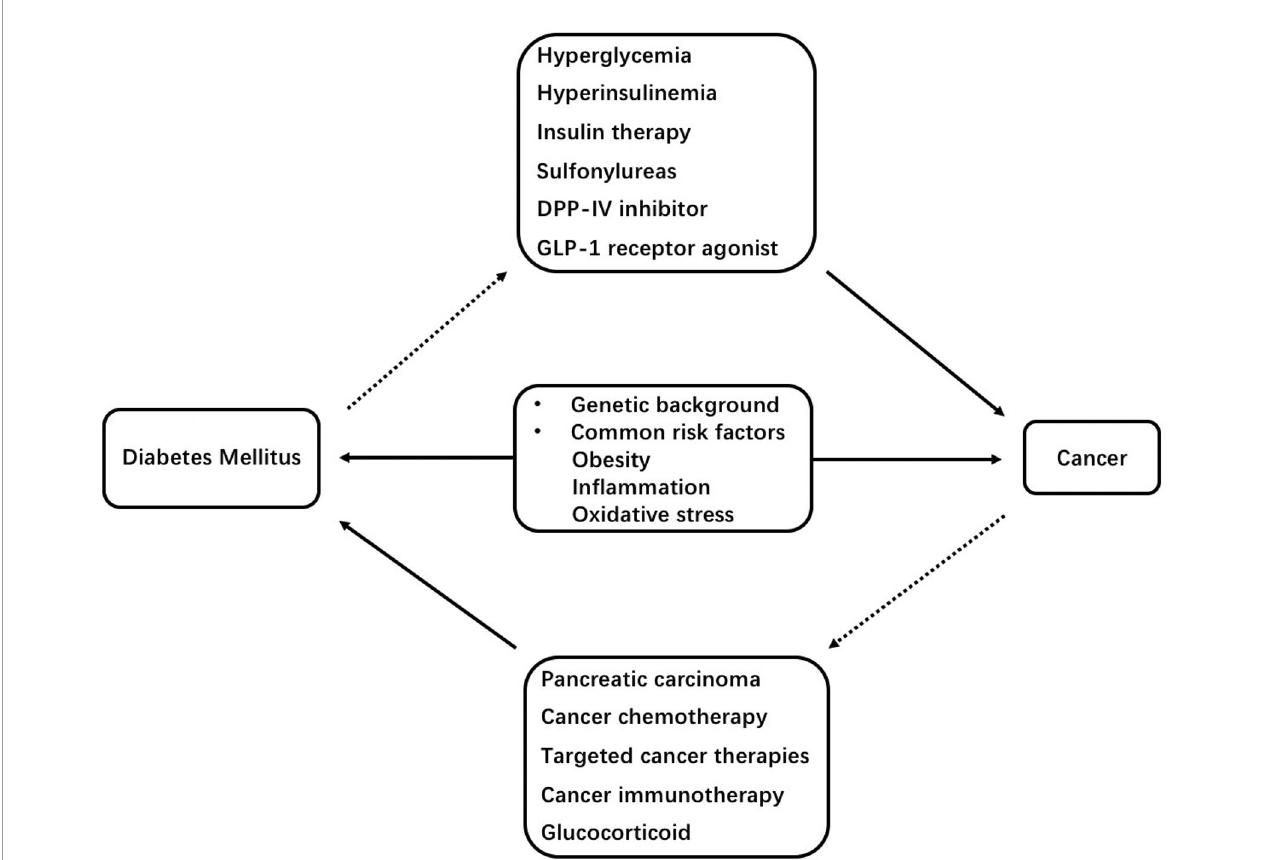
FIGURE 1 | Schematic representation of mechanisms underlying the association between diabetes mellitus and cancers. DPP-IV, dipeptidyl peptidase-IV; GLP-1, glucagon-like